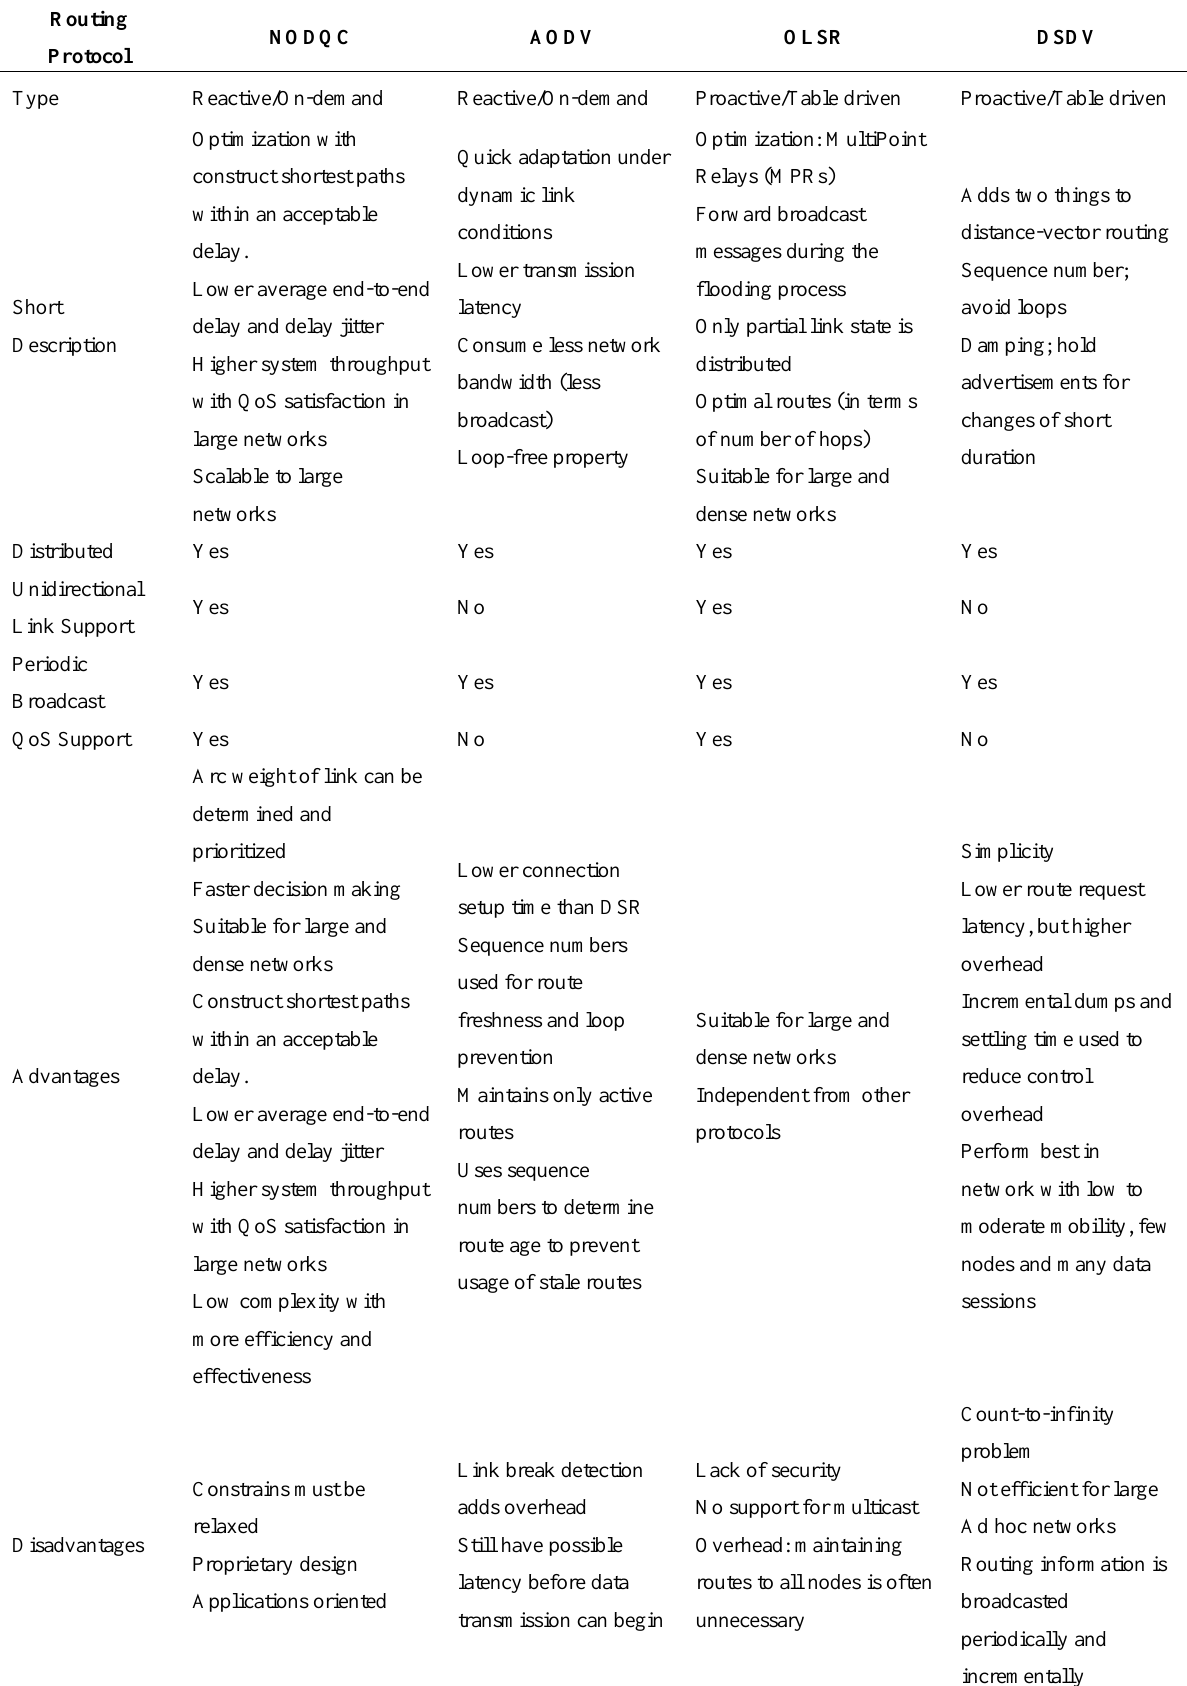
Table 1. Routing protocol